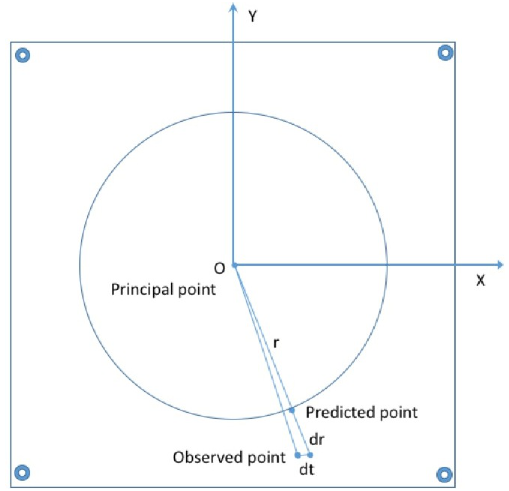
Figure 1. Point shifted by distortion.